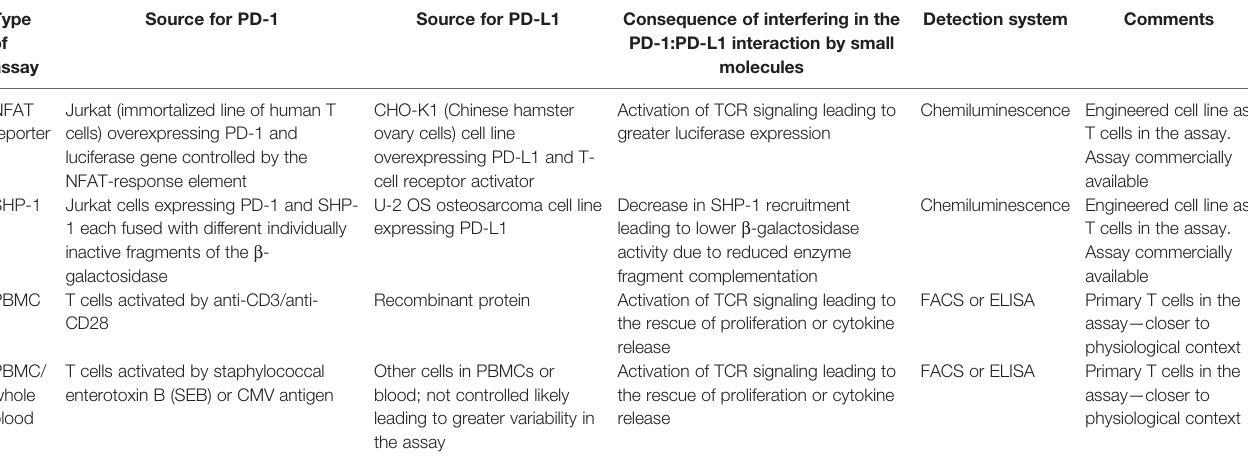
TABLE 2 | Most commonly used functional assays to monitor the impact of small molecule agents on PD-1